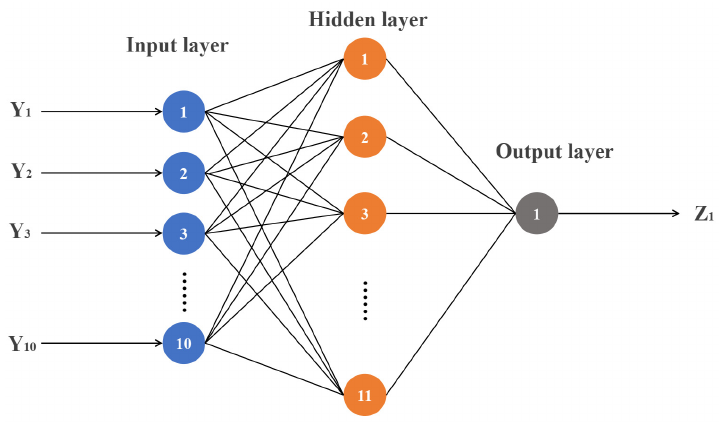
Figure 2. Network topology.